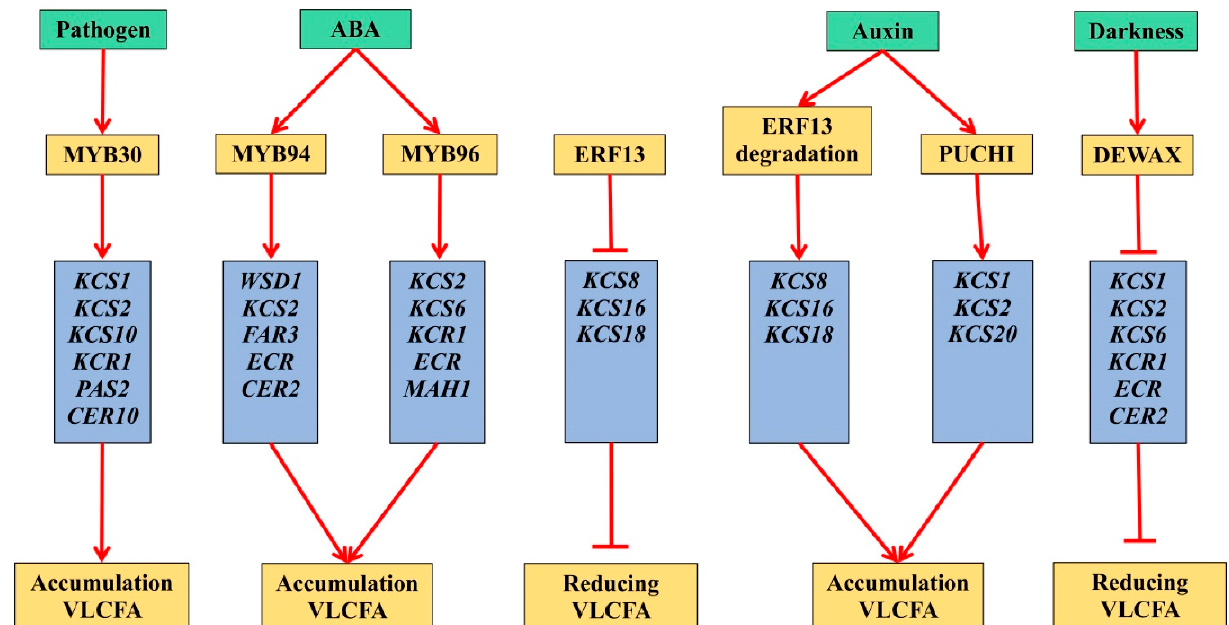
Figure 5. The regulation of the synthesis of VLCFA in plant cells. The diagram shows four tran- scription factors (MYB30, MYB94, MYB96 and PUCHI) that positively regulate VLCFA synthesis, and two (ERF13 and DEWAX) regulate it negatively. Pathogen-induced MYB30, ABA-dependent MYB94, MYB96 and auxin-dependent PUCHI activate the expression of genes for VLCFA biosyn- thesis, which leads to the accumulation of VLCFA in the cell. ERF13 and darkness-induced DEWAX suppress the expression of elongase complex genes and reduce the synthesis of VLCFA in the cell. Auxin-dependent degradation of the ERF13 results in the induction of KCS8, KCS16 and KCS18 gene expression and the accumulation of VLCFA in the cell. Arrows indicate a positive regulation. Lines ending with a bar indicate a negative regulation.